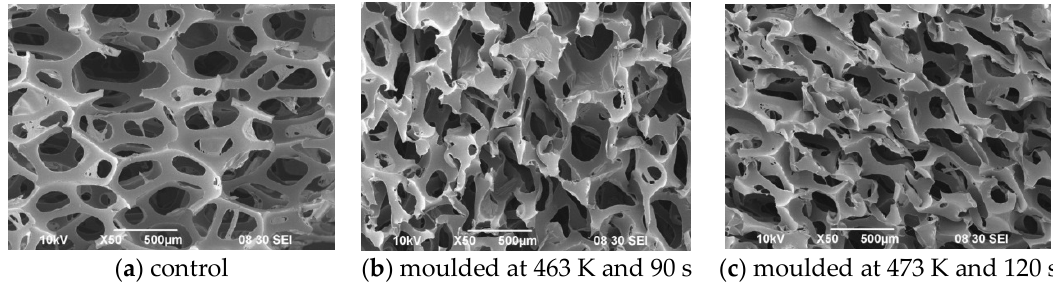
Figure 2. Cellular structure of PU foam (Foam I) under different moulding conditions.